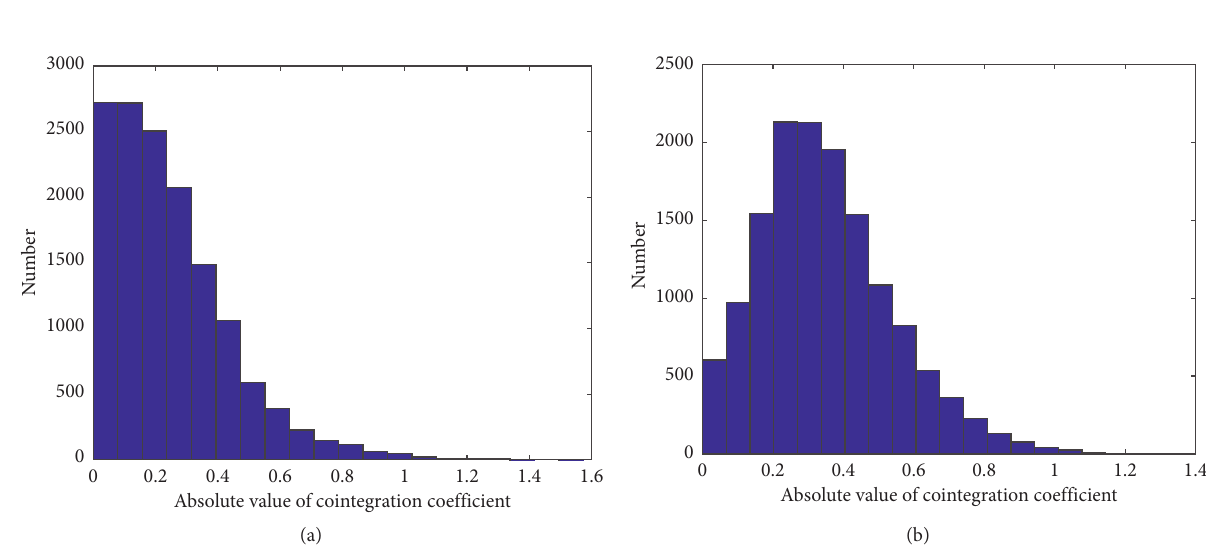
Figure 3: Distribution diagram of the absolute value of the cointegration coefficient during 2016-2017 (a) and 2017-2018